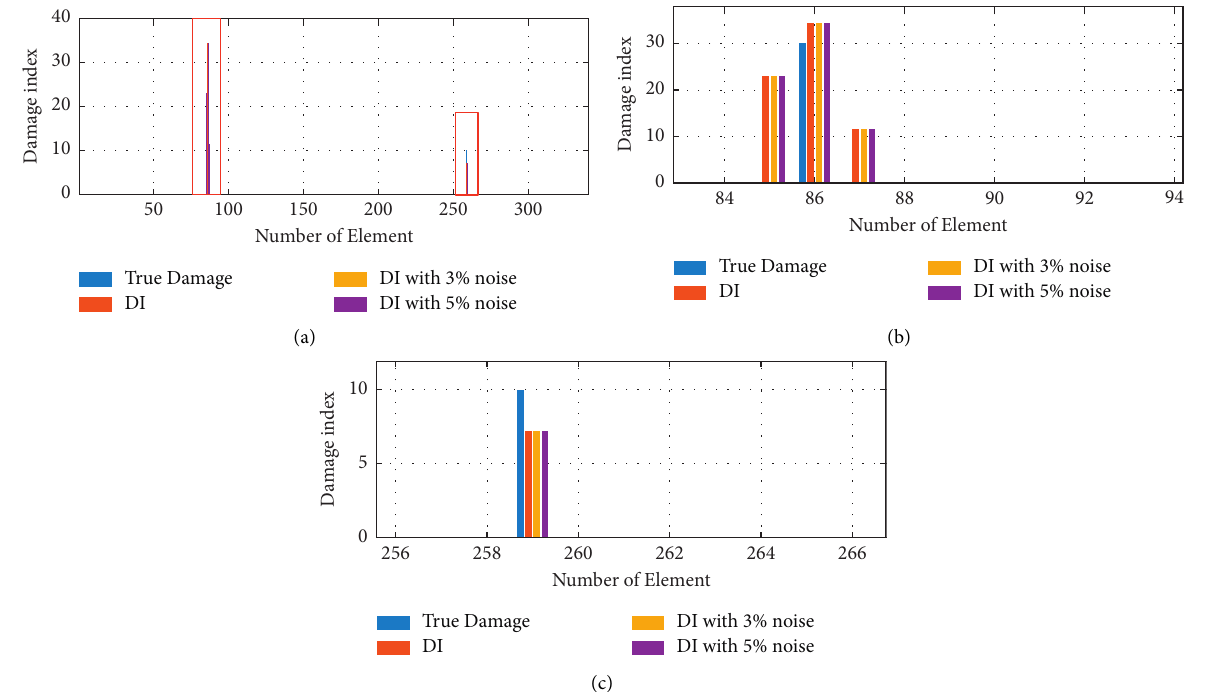
Figure 15: Results of multiple-damage scenario D4 containing measurement noise. (a) Original result. (b) Zoomed result part 1. (c) Zoomed result part 2.